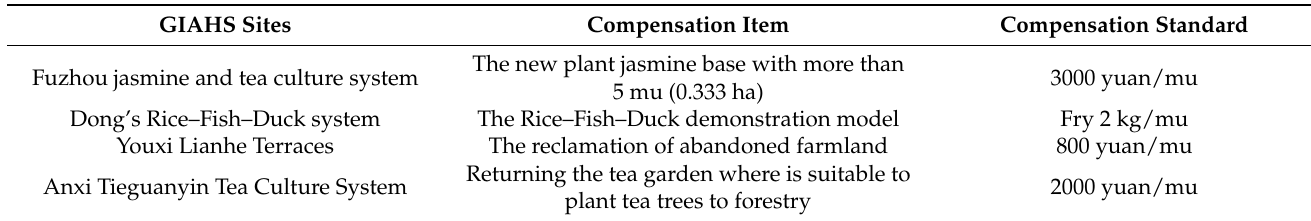
Table 2. Compensation Policies in Different GIAHS